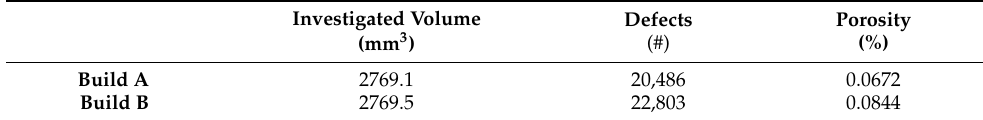
Figure 7. ( a ) Tomogram showing the porosity in a test specimen. ( b ) Distributions of the defect size (equivalent diameter) of segmented defects. Data are combined from XCT scans of six specimens from each of the two builds. Table 4. Average porosity levels as evaluated from